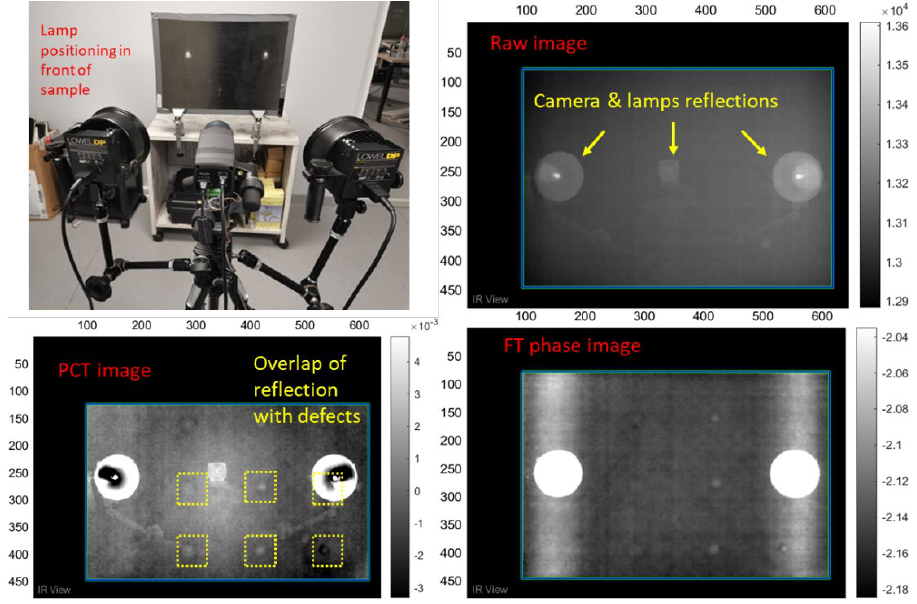
Figure 5. Reflections due to low emissivity of the samples and their effect on acquisitions. Table 5. Distances between